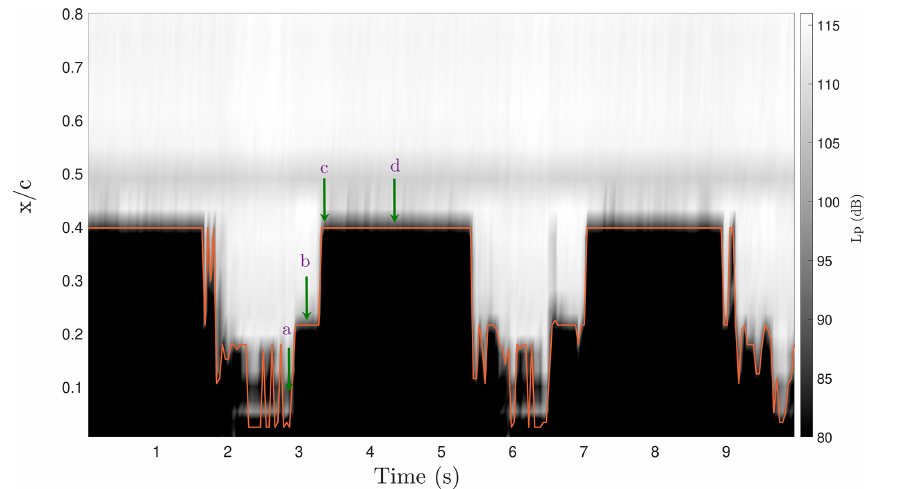
Figure 5. Chordwise pressure levels ( L p ) with a line of detected transition locations. The arrow indicates the time instances where the chordwise PSD values were plotted in Fig. 6.